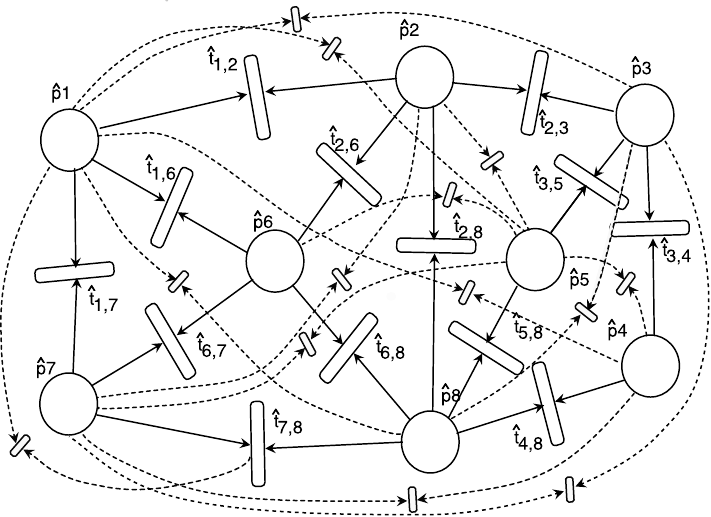
Figure 5. Binary Quadratic Net of Graph Partitioning Problem for Instance shown in Figure